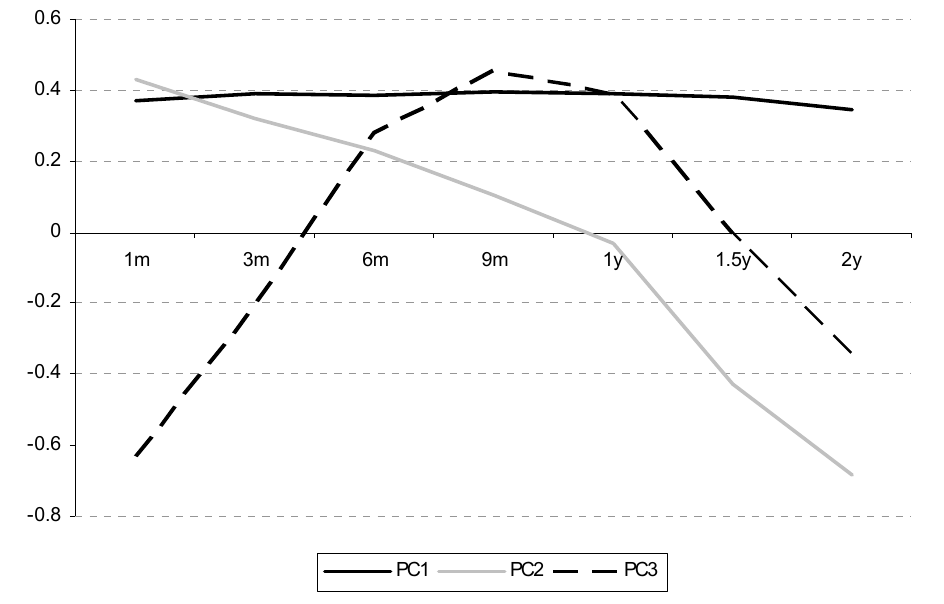
Figure A1. Loadings of the first three principal components.